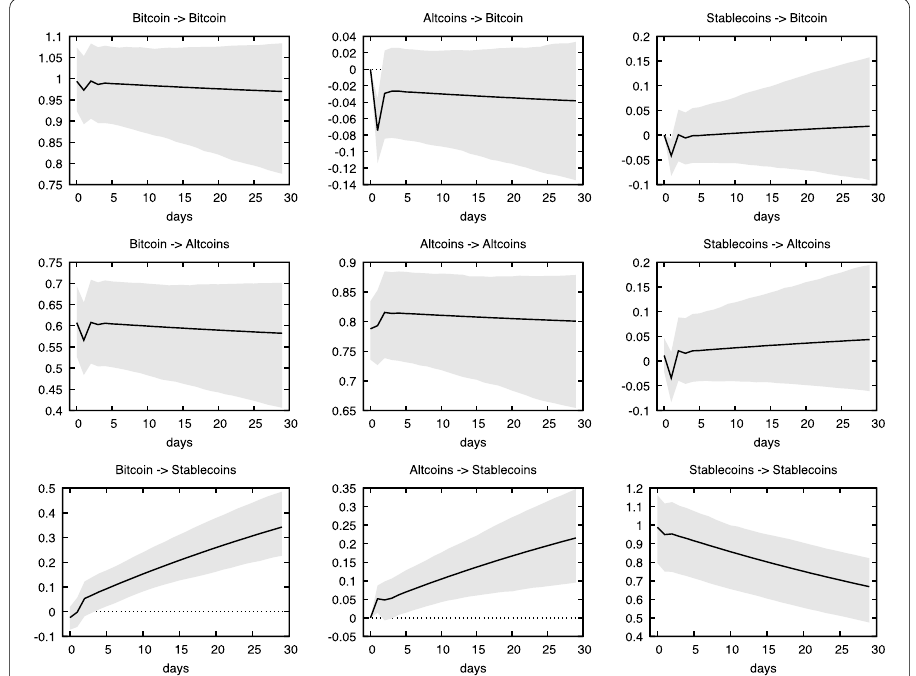
Fig. 5 Impulse-response functions of market capitalizations (short run). Impulse response functions based on the cointegrated VAR with 2 lags and an unrestricted trend are shown for the time horizon of 30 days ( x -axes), with a standard deviation of the given series as a unit of measurement. The rest of the notation holds from Fig. 2